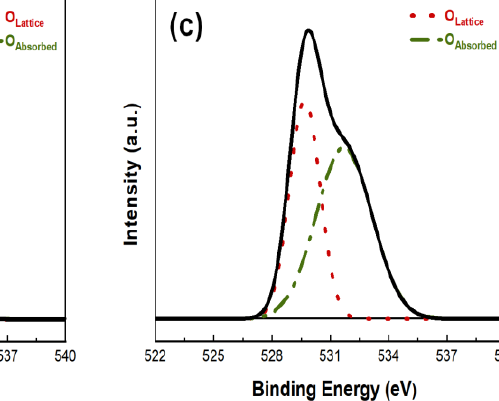
Figure 5. X-ray photoelectron spectrum of O 1s ( a ) CFO ( b ) CO-CFO-12.5 ( c ) CO-CFO-25 ( d ) CO- CFO-37.5, and ( e ) CO. 3.2. Electrochemical Measurement Figure 6 shows the ORR results for CFO, CO-CFO-X, and CO metal oxides. Pt/C, known to have a low onset potential and high ORR activity, was measured under the same conditions as CO-CFO-X. In Figure 6a, Pt/C shows high ORR activity with a limiting current density value of −3 .8 mA/cm 2 at −0 .2 V. In the ORR curve (Figure 6a), the CO sample with a low specific surface area (24.92 m 2 /g) has a current density value of −1 .6 mA/cm 2 , and the CFO sample with a high specific surface area (104.71 m 2 /g) has a current density value of −3 .4 mA/cm 2 . The current density in the diffusion-controlled region was determined by the diffusion rate of oxygen, i.e., the higher the current density value of the diffusion-controlled region, the higher the electrocatalytic activity for ORR. The diffusion current is affected by the geometric surface of the electrode, and the current density increases with specific surface area [57,58]. The onset potentials of CFO, CO-CFO-12.5, CO-CFO-25, CO-CFO-37.5, and CO were −0 .278 V, −0 .270 V, −0 .270 V, −0 .279 V, and −0 .297 V, respectively. The electrochemical and catalytic properties are similar because the nanocomposites are based on Co materials. However, compared to CFO, the onset potential and current density of the CO sample were lower, indicating low ORR performance. Despite the increase in the ratio of CO, the CO-CFO-X nanocomposite showed a slightly improved ORR performance compared to CFO owing to the formation of nanoparticles and the increase in oxygen vacancies. Many studies have reported that the improvement in ORR properties is related to the formation of oxygen vacancies on the